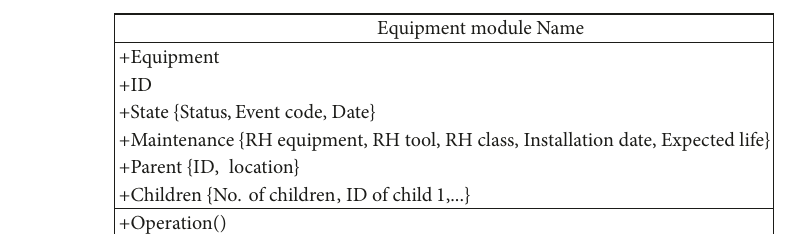
Figure 2: Activity models of maintenance operations management [11].